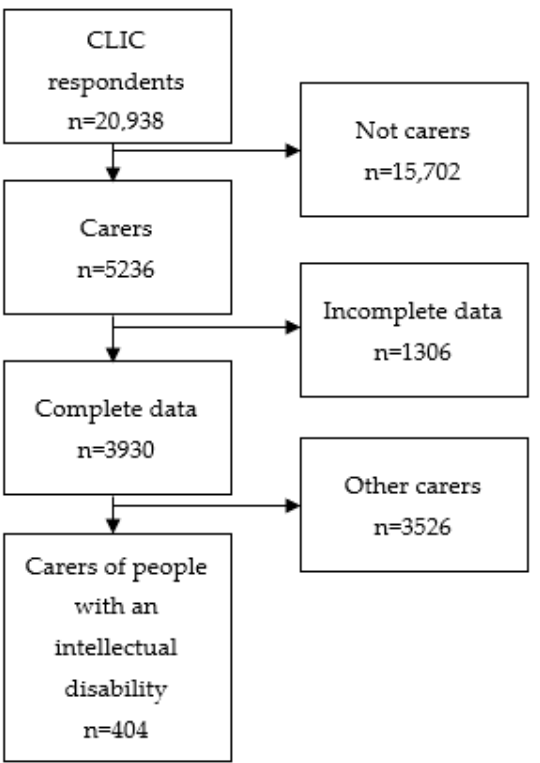
Figure 1. Flow diagram of participant numbers.